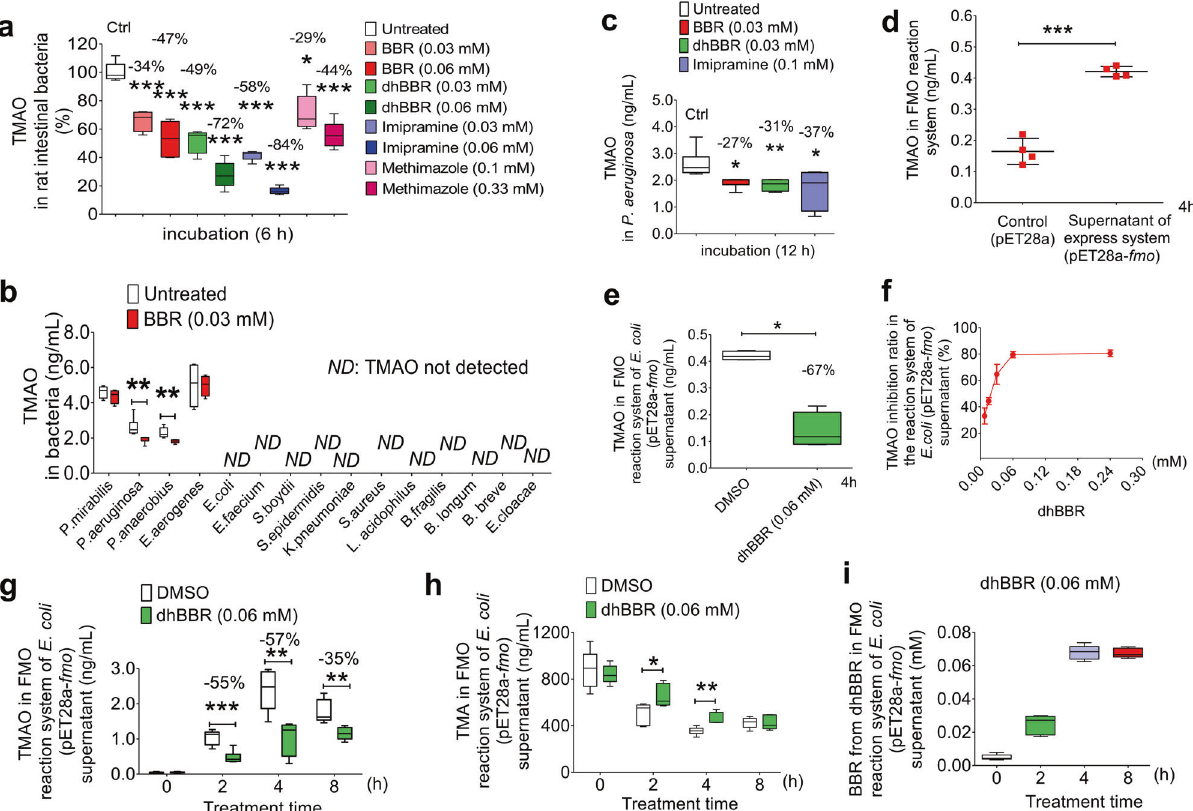
Fig. 4 DhBBR inhibited TMAO generation by targeting bacterial fl avin-containing monooxygenase (FMO) in gut. a Both BBR and dhBBR (0.03, 0.06 mM) inhibited TMAO production in intestinal bacteria ( n = 5, *** P < 0.001), and the known FMO inhibitors (imipramine and methimazole) showed an inhibition as well. b The effect of BBR (0.03 mM) on TMAO production in vitro was tested in 15 intestinal bacterial strains, of which TMAO was detected in P. mirabilis , P. aeruginosa , P. anaerobius and E. aerogenes . In P. aeruginosa and P. anaerobius , TMAO showed a decrease after BBR treatment ( n = 5, ** P < 0.01). c BBR, dhBBR (0.03 mM) and imipramine (inhibitor of FMO, 0.1 mM) decreased TMAO level in P. aeruginosa after incubation for 12 h ( n = 6, * P < 0.05, ** P < 0.01). d The conversion from TMA to TMAO increased in the FMO-expressed reaction system (pET28a- fmo ) after 4 h incubation ( n = 4, *** P < 0.001). e BBR and dhBBR (0.06 mM) inhibited the transformation from TMA to TMAO in a heterologously FMO-expressed reaction system ( E. coli with pET28a- fmo transformation) at 4 h after incubation ( n = 4, * P < 0.05). f The inhibition ration (%) of TMAO production in the FMO-reaction system (in E. coli with pET28a- fmo ) was dose-dependent ( n = 4). g , h DhBBR (0.06 mM) inhibited the production of TMAO ( g ) and increased the level of TMA ( h ) in the FMO-expression reaction system ( E. coli pET28a- fmo , n = 6, * P < 0.05, ** P < 0.01, *** P < 0.001). i DhBBR was transformed into BBR in the FMO reaction system ( E. coli pET28a- fmo ), n = 6. Data shown are mean ± SD and analysed with two-tailed student ’ s t